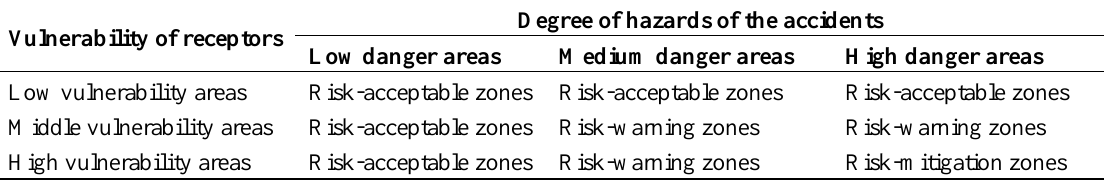
Table 2. Regional environmental risk zoning